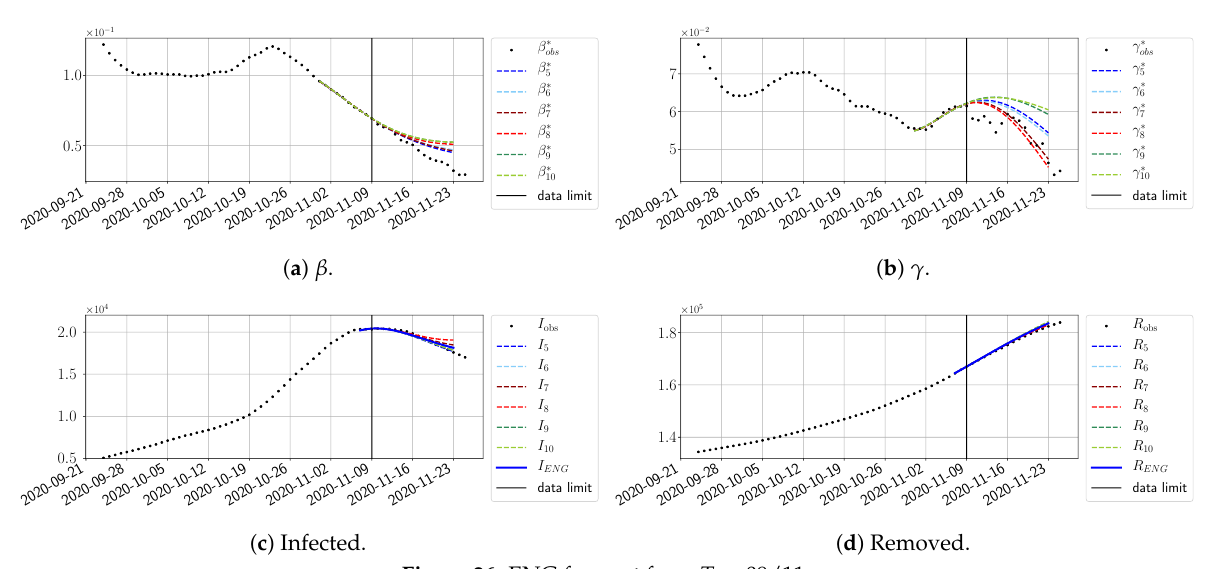
Figure 25. ENG forecast from T = 03/11.